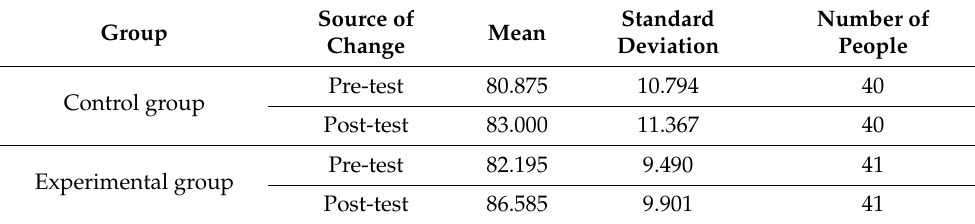
Table 9. Summary table of descriptive